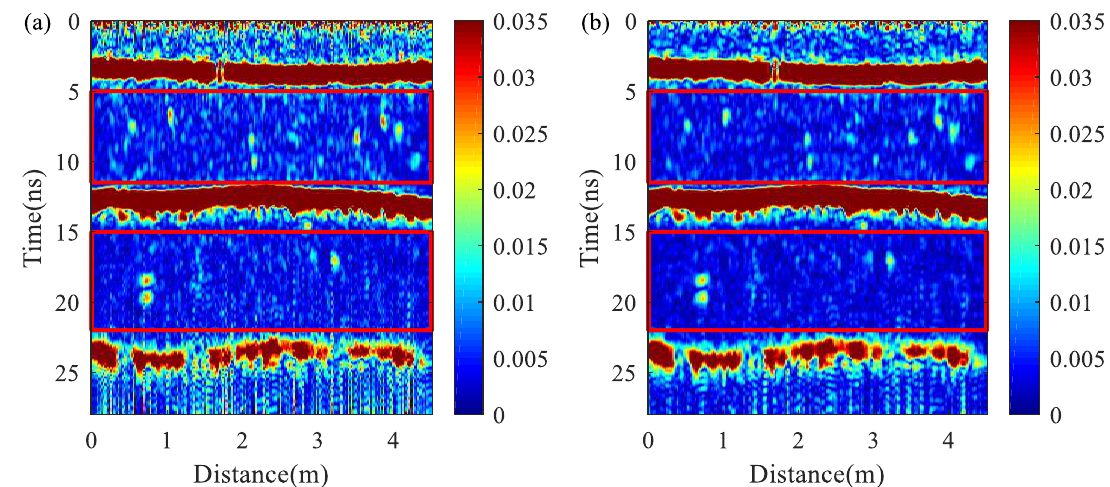
Figure 5. Instantaneous amplitude profiles. ( a ) Original profile. ( b ) 2D-PCA processing results.